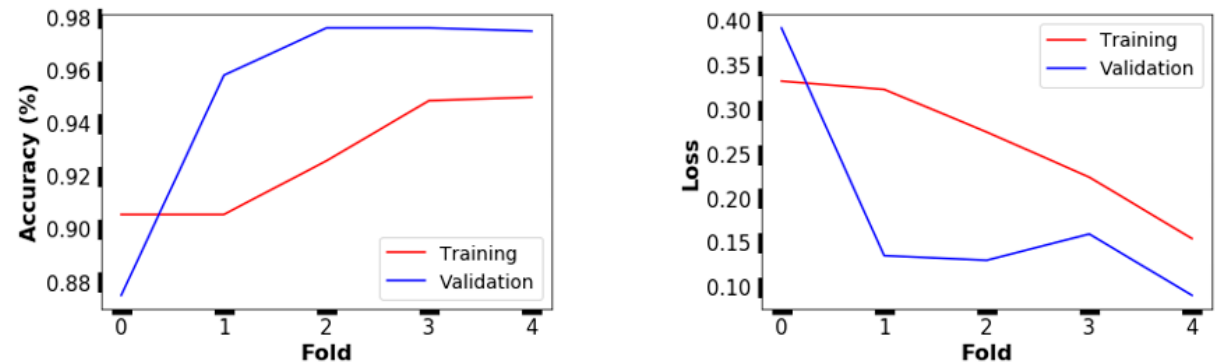
Figure 4. Performance of the VGG16-based model with three dense layers (including 512, 512, and 256 neurons; Table 1) on the training and validation dataset in every five folds.